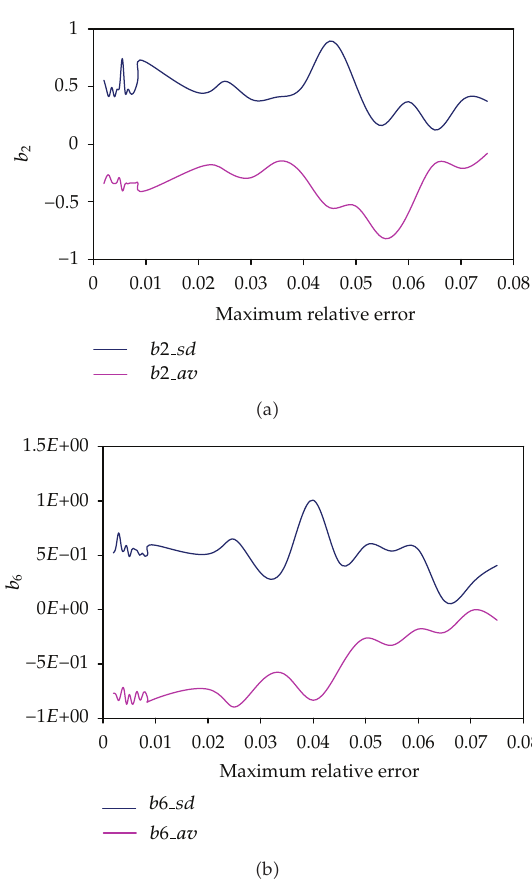
Figure 7: Average and standard deviation value for parameter b versus ε , for the Dow Jones (cid:2) a (cid:3) and Nikkei (cid:2) b (cid:3)